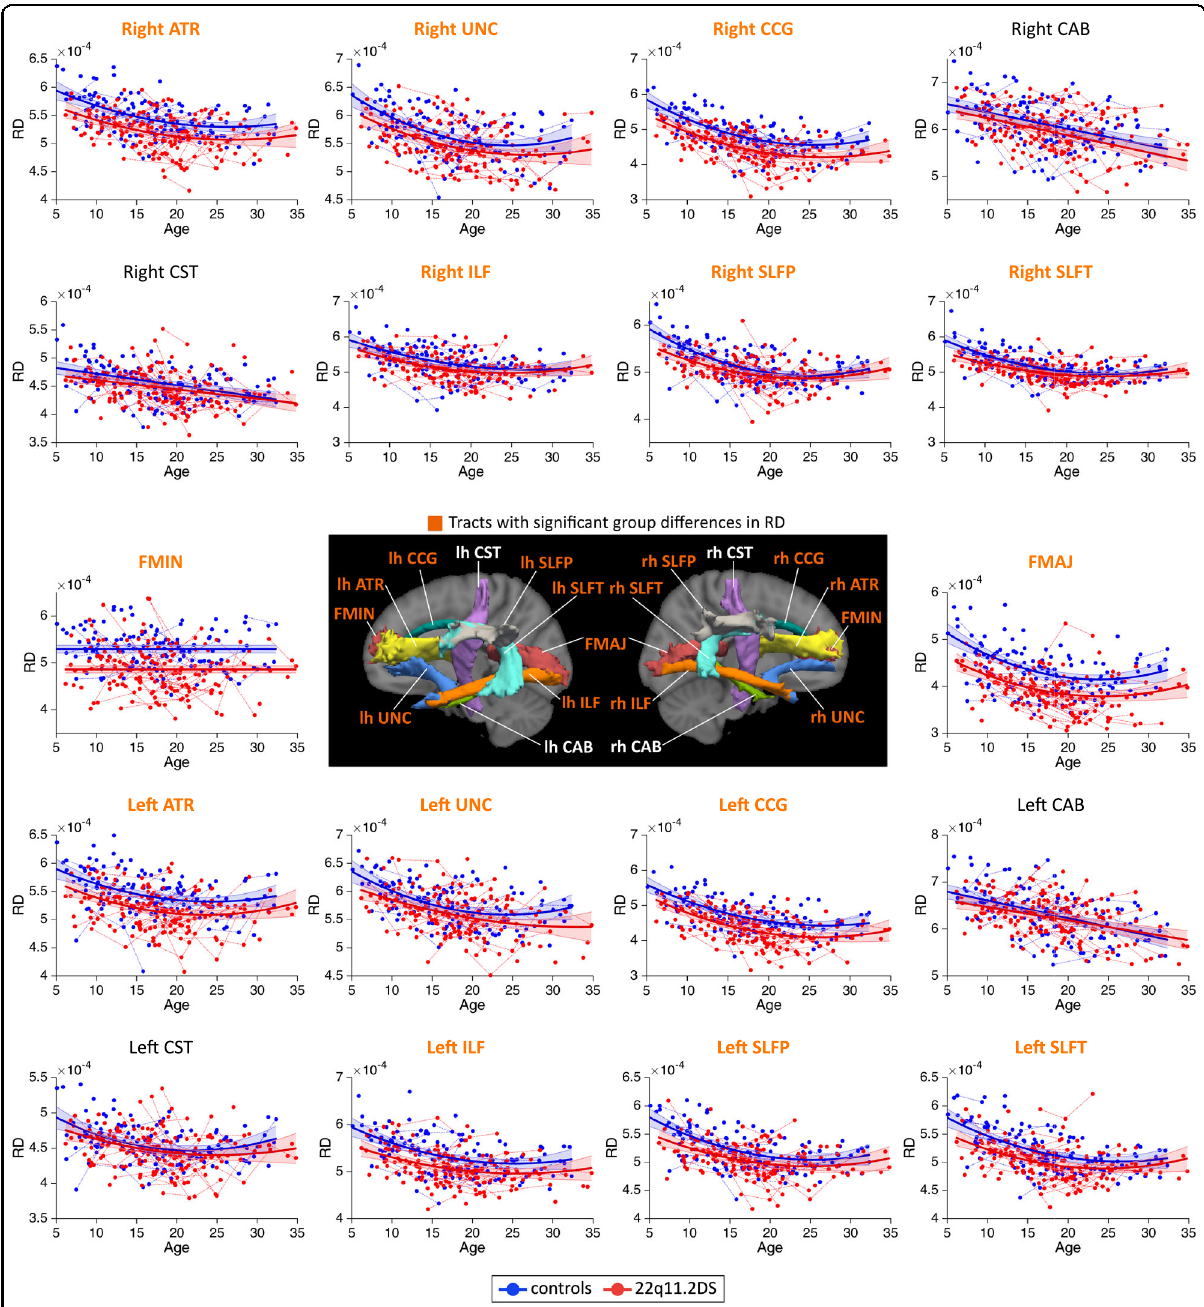
Fig. 3 Developmental trajectories of radial diffusivity (RD) in patients with 22q11.2DS and controls. RD metrics mostly followed quadratic decreasing trajectories in 22q11.2DS (red) and controls (blue). Similar to other diffusion measures, age × group interactions were absent and both groups therefore displayed identically shaped developmental curves. Group differences were evident in a majority of white matter tracts, with systematic reductions of RD in individuals with 22q11.2DS. Tracts with signi fi cant group differences are highlighted in orange in plot titles and in the central fi gure. The signi fi cance threshold was set at p < 0.05. All results were corrected for multiple comparisons using the FDR method. lh left hemisphere, rh right hemisphere, FMAJ forceps major, FMIN forceps minor, ATR anterior thalamic radiation, CAB cingulum – angular bundle, CCG cingulum – cingulate bundle, CST corticospinal tract, ILF inferior longitudinal fasciculus, SLFP superior longitudinal fasciculus – parietal bundle, SLFT superior longitudinal fasciculus – temporal bundle, UNC uncinate